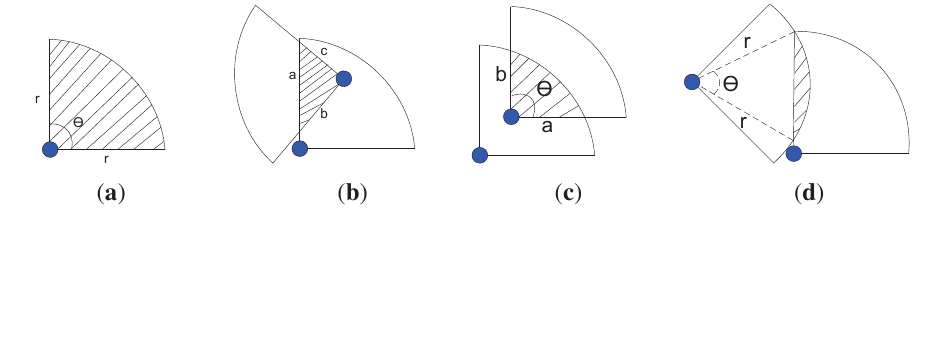
Figure 5. Different types of overlapping. ( a ) Candidate sector; ( b ) Case 1; ( c ) Case